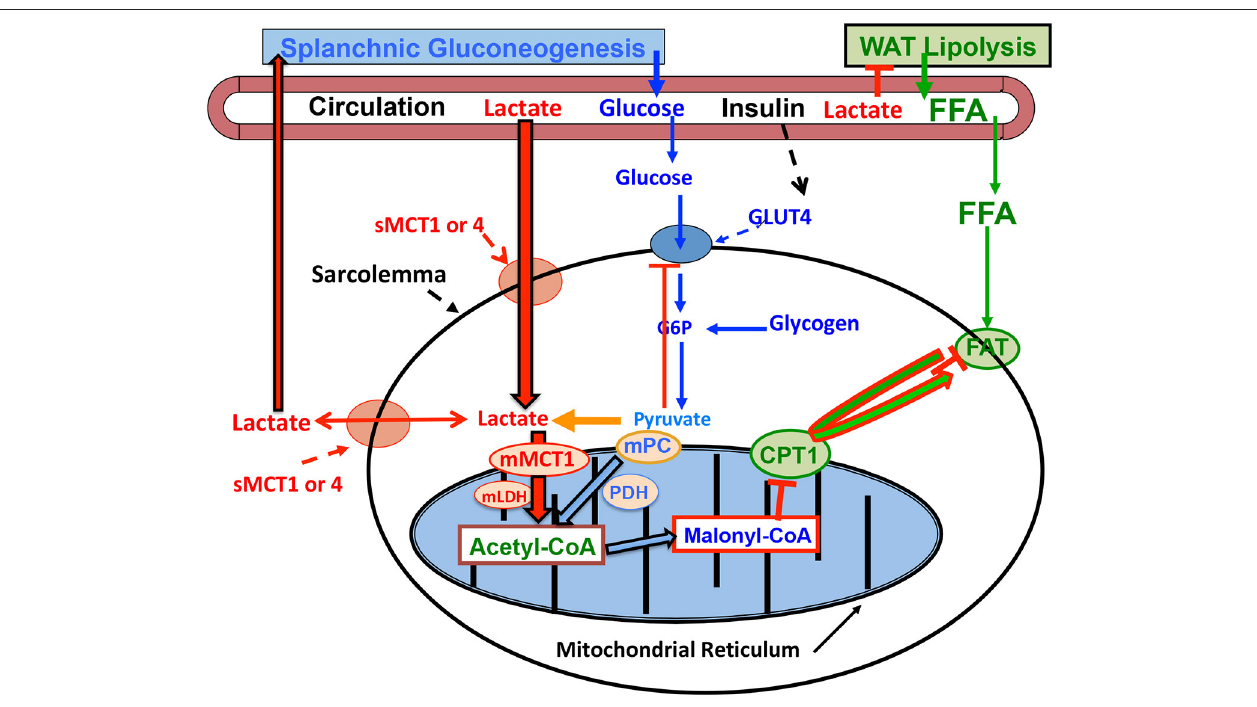
FIGURE 3 | Illustration of how lactatemia affects crossover from lipid- to lactate-based metabolism in cardiac and skeletal muscle. Lactate is the inevitable consequence of glycolysis (63), the minimal muscle L/P being 10 and rising to an L/P > 100 when glycolytic flux is high (64). Lactate availability as a myocardial energy source increases during physical exercise because arterial lactate concentration rises ( 27, 55), but also as the result of increased cardiac work and glycolytic flux during exercise ( 28, 29) or as the result of pacing (12). As the favored Oxidizable substrate, lactate catabolism results in product inhibition of glucose and FFA oxidation. As the products of glycolysis, lactate and pyruvate provide negative feedback inhibition of glucose disposal (blue dashed lines). Also as the predominant mitochondrial substrate, lactate gives rise to Acetyl-CoA, and in turn Malonyl-CoA. Acetyl-CoA inhibits β -ketothiolase, and hence β -oxidation, while Malonyl-CoA inhibits mitochondrial FFA-derivative uptake via CPT1 ( T ) ( 76). Moreover, lactate is the main gluconeogenic precursor raising glucose production and blood (glucose) (red lines). Via GPR81 binding, lactate inhibits lipolysis in WAT ( T ) depressing circulating (FFA) (77, 78). This model explains the paradoxical presence of lactatemia in high-intensity exercise and insulin-resistant states with limited ability to oxidize fat (green lines). Modified from Hashimoto et al. (79). CPT1, carnitine palmitoyl transporter-1; FFA, free fatty acid; FAT, fatty acid translocator composed of CD36 and FABPc; GLUT, glucose transporter; s, sarcolemmal; m, mitochondrial. Malonyl-CoA formed from exported TCA citrate controlled by the interactions of Malonyl-CoA decarboxylase (MCD) and acetyl-CoA carboxylase (ACC). MCT, monocarboxylate transporter; MPC, mitochondrial pyruvate transporter; PDH, pyruvate dehydrogenase; WAT, white adipose tissue; T , inhibition. Not shown is fatty acyl-Co (FA-CoA) that will accumulate if FFAs are taken up by myocytes, but blocked from mitochondrial entry by the effect of Malonyl-CoA on CPT1. Accumulated intracellular FA-CoA will give rise to intramyocellular triglyceride (IMTG) and the formulation of LC-FA, DAG, and ceramides via inhibition of PI3 kinase (PI3-k) and reducing GLUT4 translocation; from (